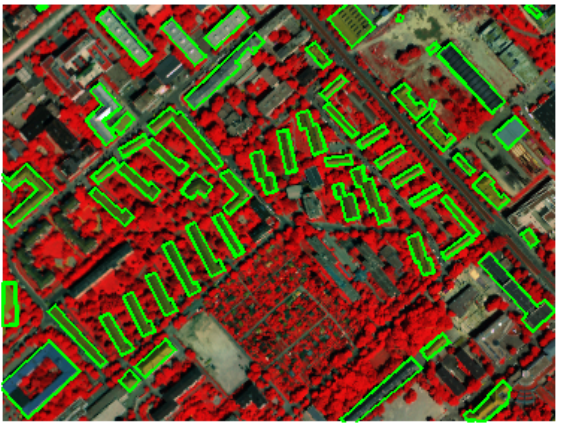
Figure 2: Detected buildings (green) in HSI. False colour com- posite image with channels of wavelength λ = 0.66, 0.51 and 0.45 µm